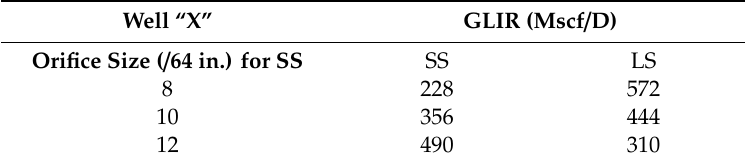
Table 6. GLIR and orifice